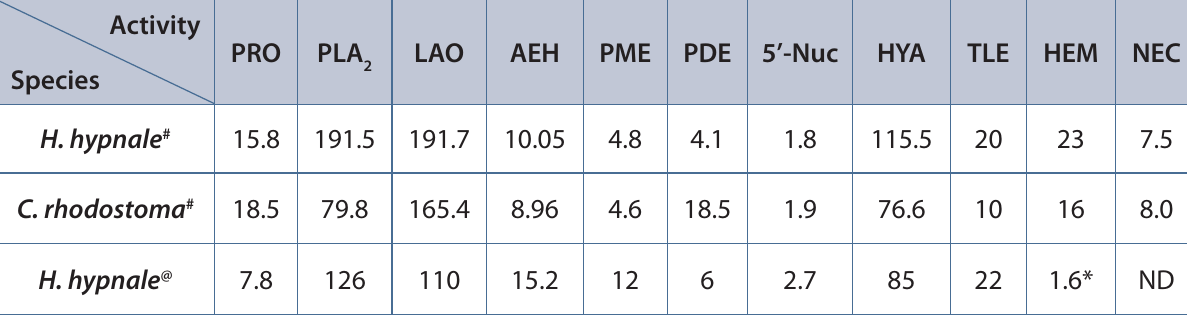
Table 1. Enzymatic, hemorrhagic and necrotic activities of H. hypnale and C. rhodostoma venoms